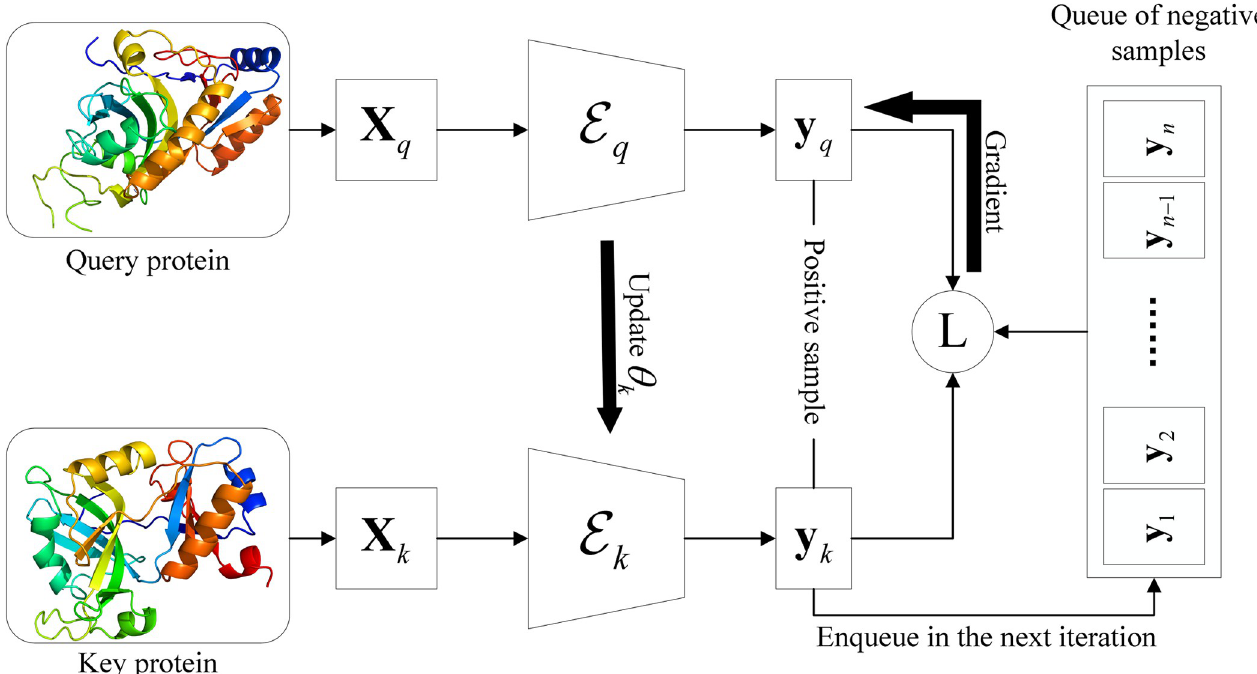
Fig 3. The contrastive learning framework for protein structure representation learning. At each iteration, raw features X q and X k are extracted from the query protein structure and the key protein structure, respectively. Then, descriptors y of loss function guides the optimization of the parameters θ enqueue as a negative sample for the next